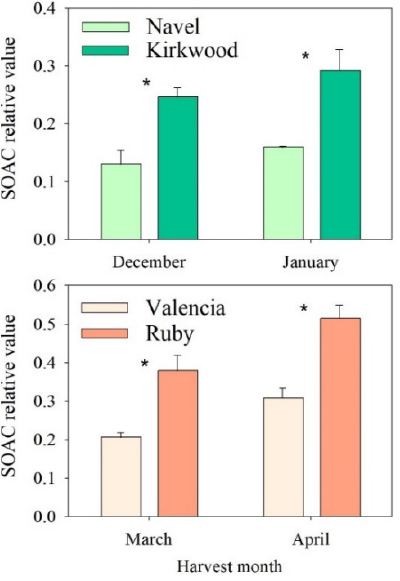
Figure 6. Singlet oxygen absorption capacity (SOAC) in the pulps of Navel and Kirkwood oranges ( upper panel ) harvested in December and January and Valencia and Ruby oranges ( lower panel ) harvested in March and April. Results are the mean of two biological replicates ± SD. Asterisks indicate significant differences between the red-fleshed K and R and the respective ordinary orange varieties, N and V, for each harvest month by t -test ( p ≤ 0.05).